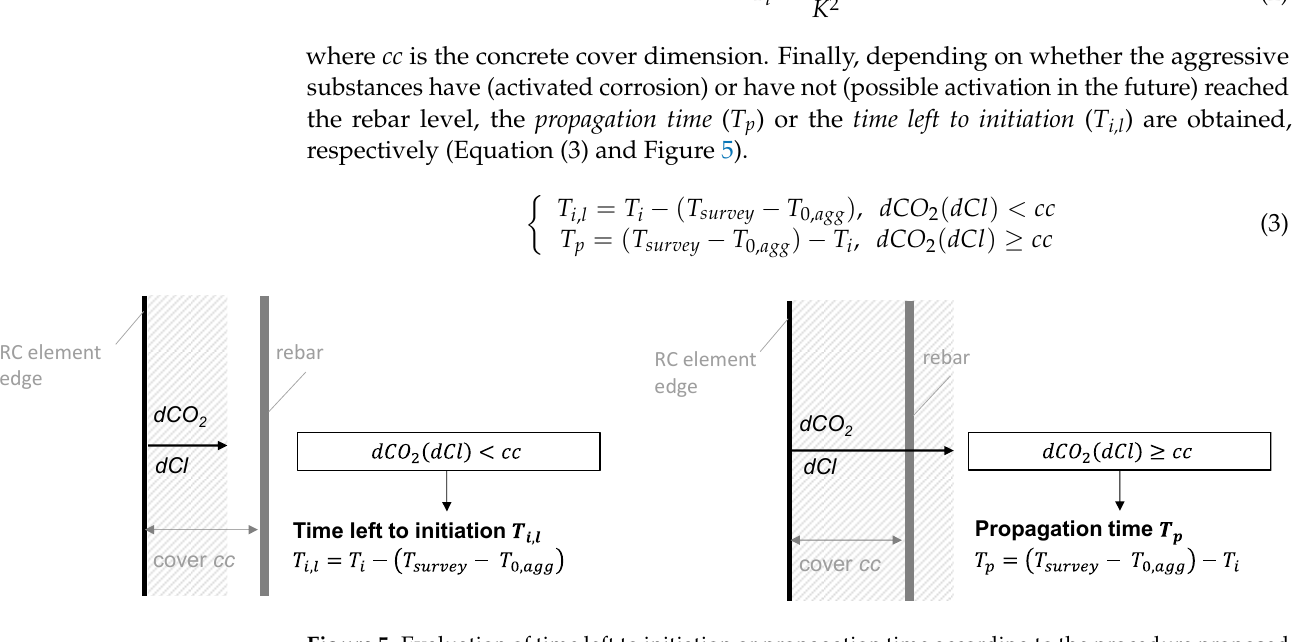
Figure 5. Evaluation of time left to initiation or propagation time according to the procedure proposed in the protocol.